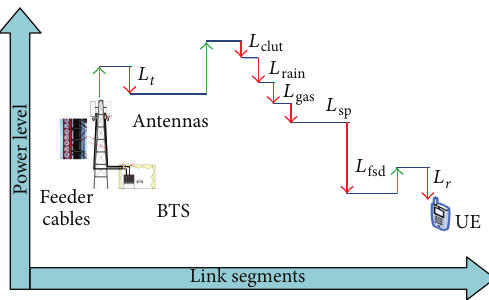
Figure 5: Link budget scheme.